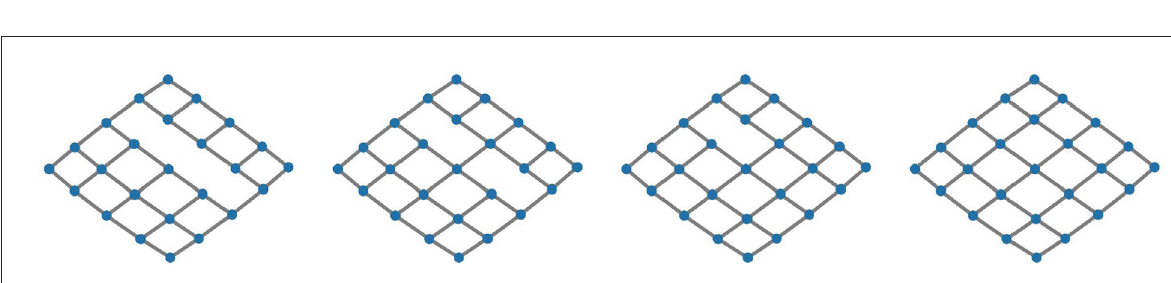
p ( t + 1 | a i ) is the network performance at time step t +